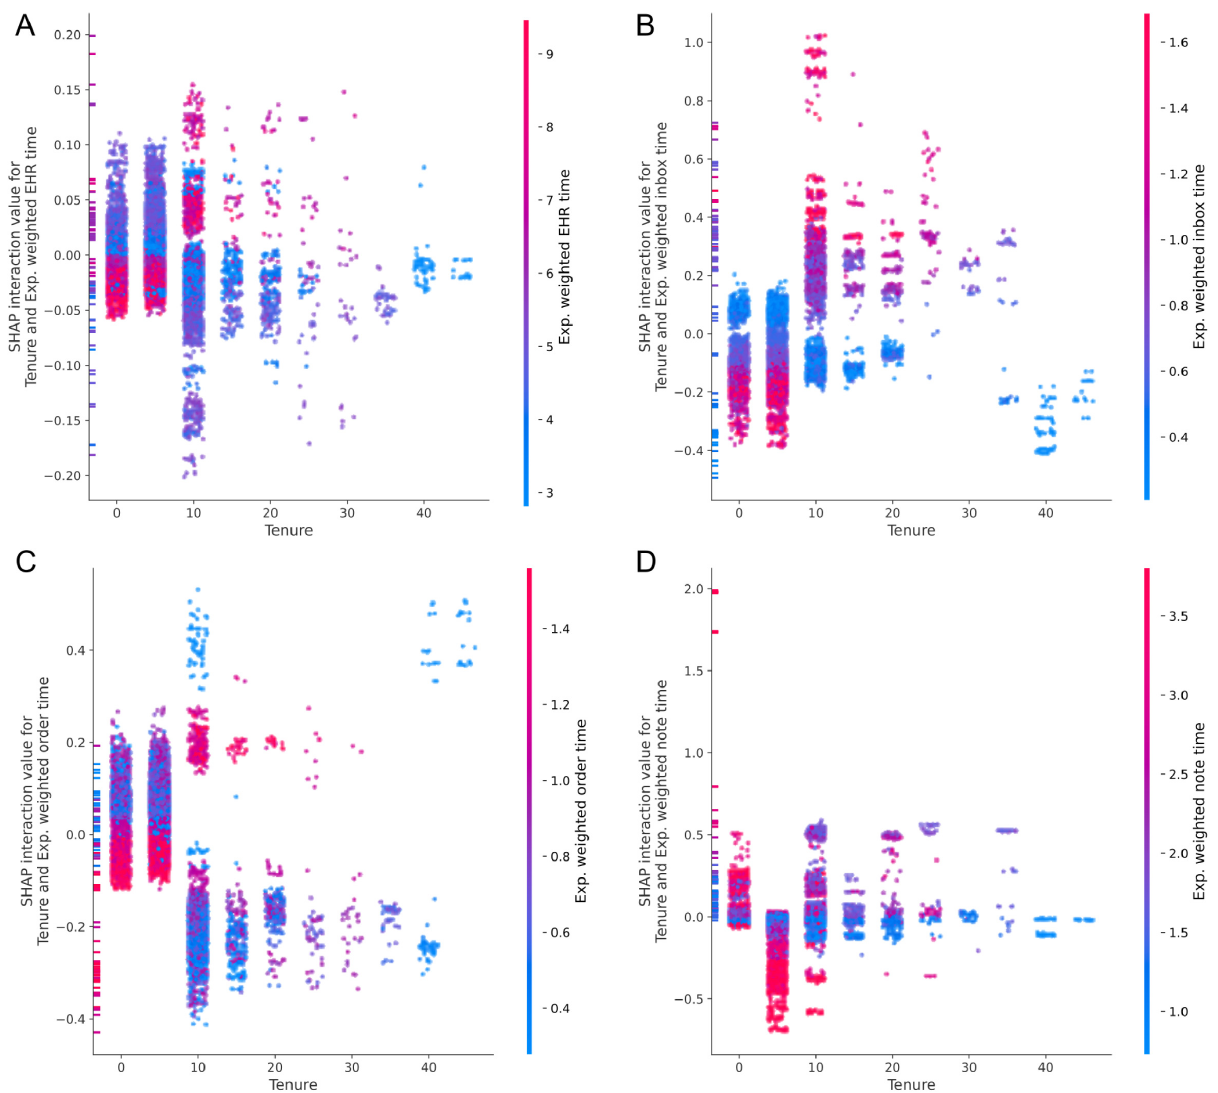
Fig 4. SHAP values for interactions between tenure and EHR use metrics. For each plot, the SHAP value for the interaction between tenure and an EHR use metric is shown as a function of tenure. The x-axis displays the value of tenure, the y-axis shows the SHAP value, and the color encodes the value of the EHR use metric. SHAP values for interactions above zero denote an increase in